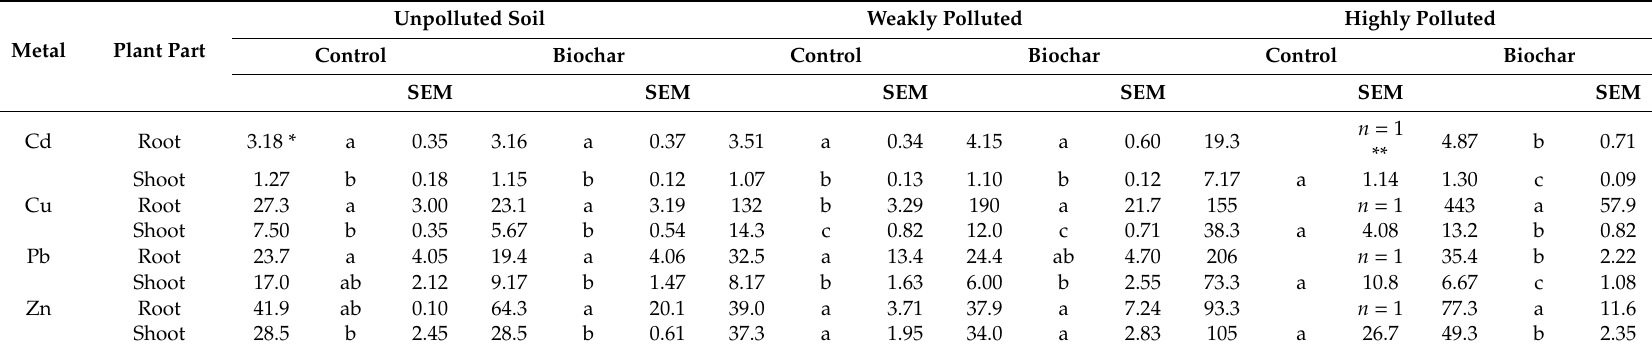
Table 3. Metal concentrations (mg / kg) in roots and shoots of barley grown in three di ff erently polluted soils amended or not with biochar (2% by weight). Unpolluted Soil Weakly Polluted Highly Polluted Metal Plant Part Control Biochar Control Biochar Control